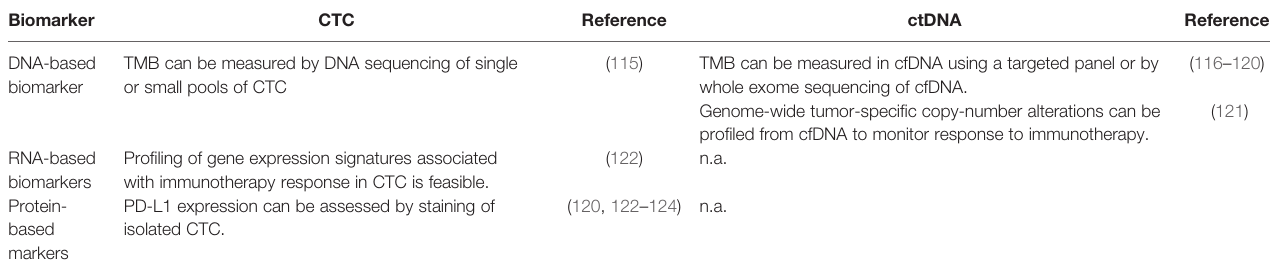
TABLE 4 | Feasibility of assessment of candidate immunotherapy biomarkers in circulating tumor cells (CTC) and circulating tumor DNA (ctDNA). Biomarker CTC DNA-based biomarker